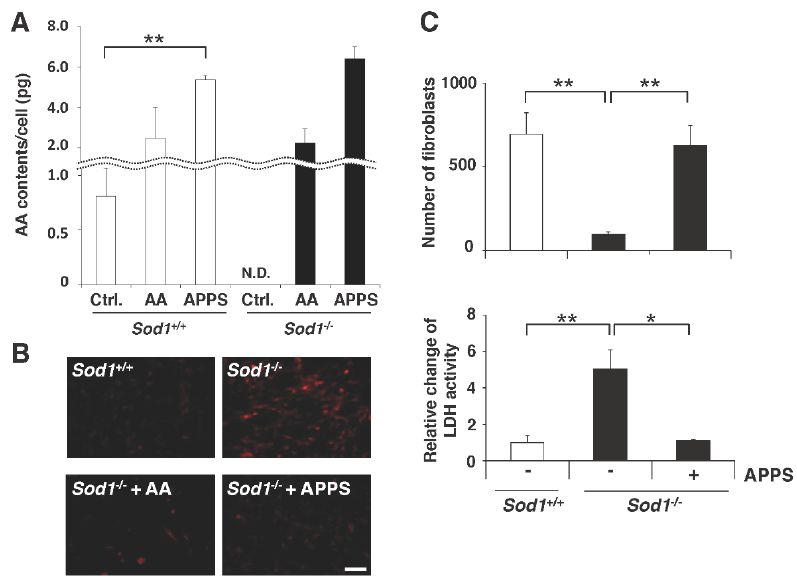
Figure 4. APPS elevates the cellular AA levels and attenuates cellular damage in skin cells. ( A ) Intracellular AA contents in Sod1 +/+ and Sod1 − / − cells treated with 10 µM AA or 10 µM APPS for 6 h; ( B ) For the measurement of intracellular reactive oxygen species, cultured Sod1 +/+ and Sod1 − / − cells treated with 10 µM AA or 10 µM APPS for 24 h were stained with dihydroethidium. The scale bar represents 100 µm; ( C ) The viability and proliferation of Sod1 +/+ and Sod1 − / − cells with or without 10 µ M APPS treatment for 96 h were analyzed. The lactate dehydrogenase activity in the conditioned medium used to culture the Sod1 +/+ and Sod1 − / − skin cells for 96 h was measured. These data represent the mean ± SEM; * p < 0.05, ** p <